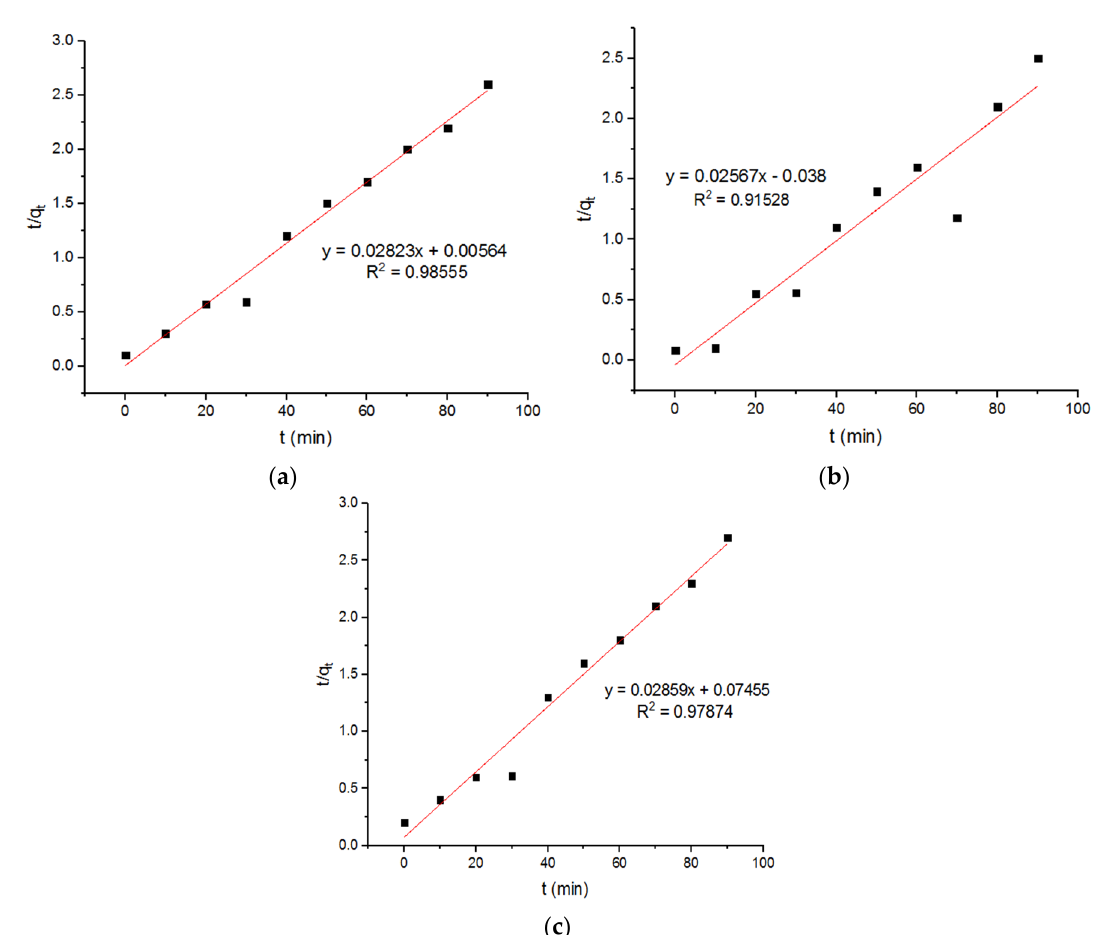
Figure 12. Pseudo-second-order plots for adsorption of Zn 2+ ions onto MgFe 2 O 4 -NH 2 nanoparticles pre-functionalization-calcined at ( a ) 500 °C, ( b ) 600 °C, and ( c ) 700 °C.